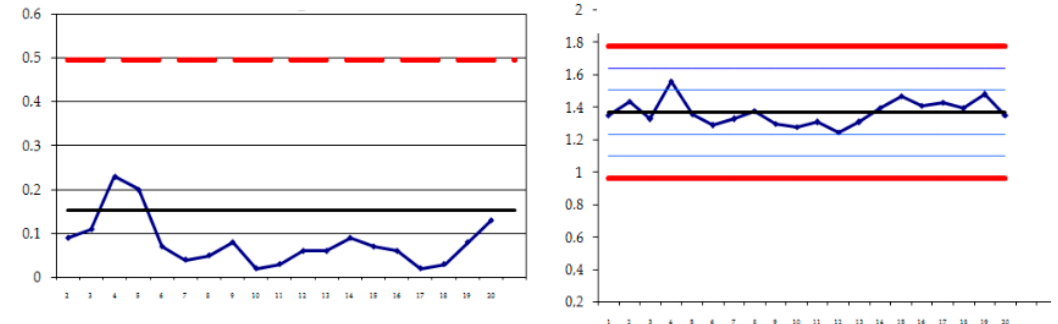
Figure 2. Shewhart’s control charts for the fixed asset index (author’s study).